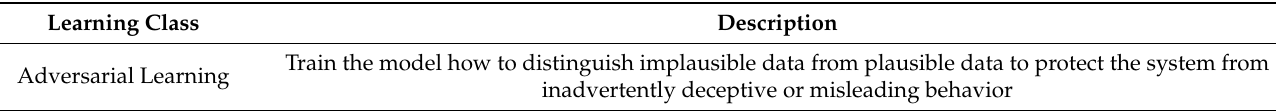
Table 1. Learning Classes Descriptions.